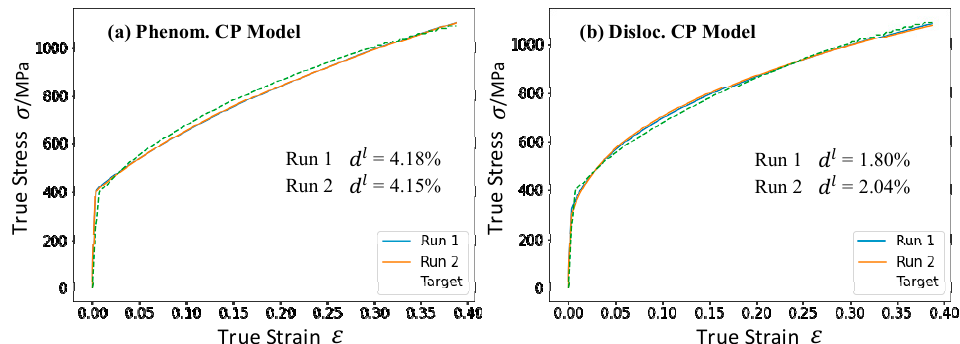
Figure 11. The stress–strain curve of best solution calculated by CP simulation in two runs (run 1, run 2), and the experiment stress–strain curve (target) in ( a ) a phenomenological CP model and ( b ) dislocation-density-based CP model. d l , as defined in Equation (1), denotes the relative difference between simulation-calculated stress–strain curve and experiment stress–strain curve in two runs.